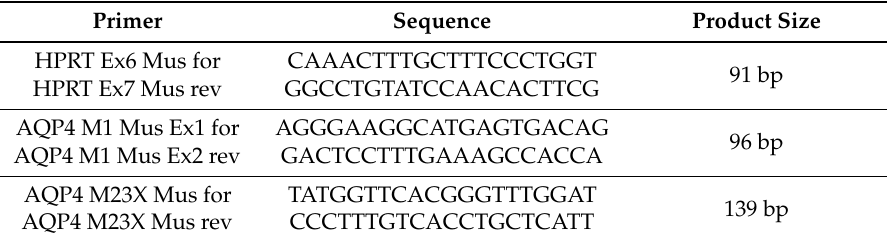
Table 4. Primer ( Mus musculus